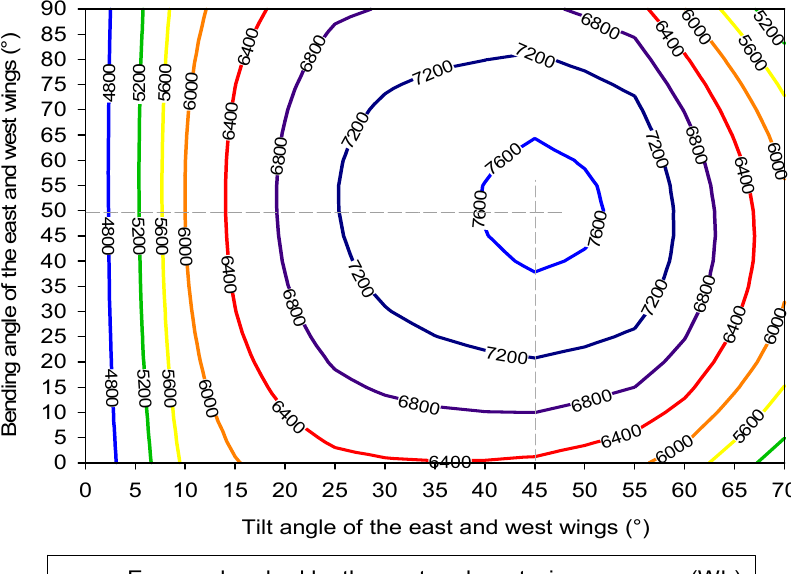
Figure 3. Sum of the energies absorbed by the east and west wings at each tilt and bending angle for all months to determine the global optimum settings for year-round